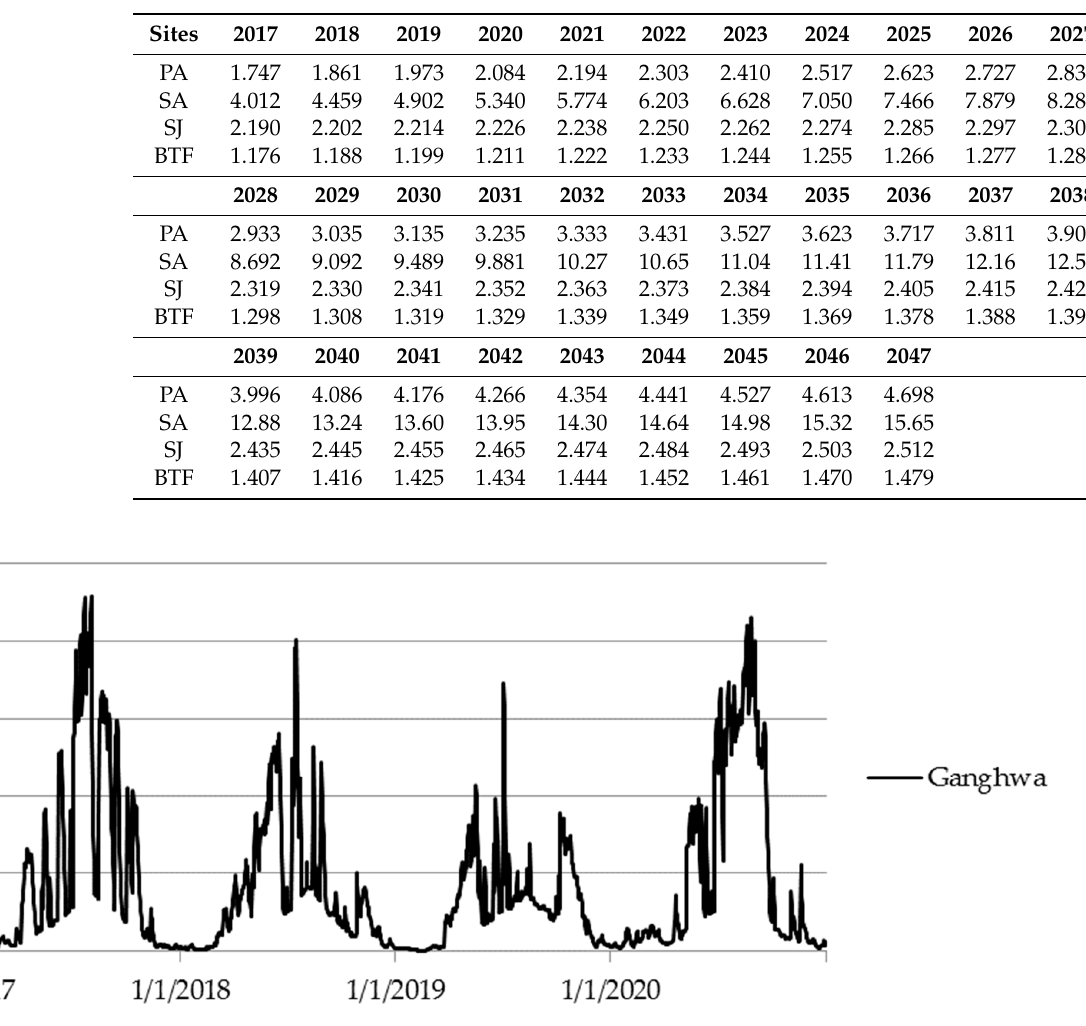
Table A3. Simulation of CH 4 emissions (kg ha − 1 yr − 1 ) over years at the four experimental sites in Ganghwa province of Korea.